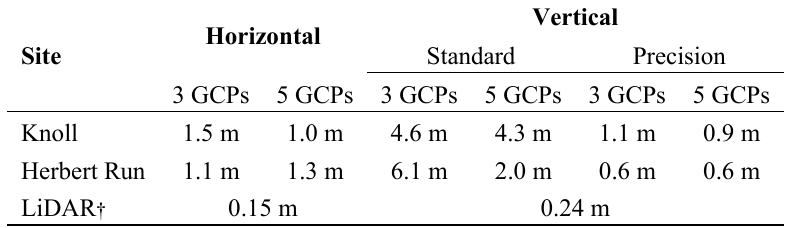
Table 2. Positional errors (RMSE) in Ecosynth and LiDAR point clouds.